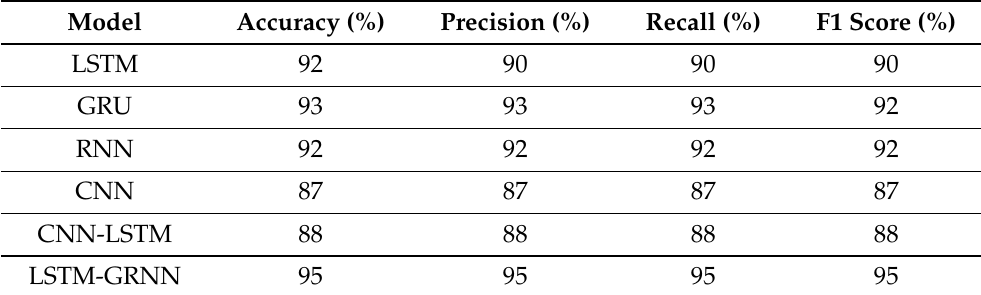
Table 17. Deep learning model performance on TextBlob sentiment.